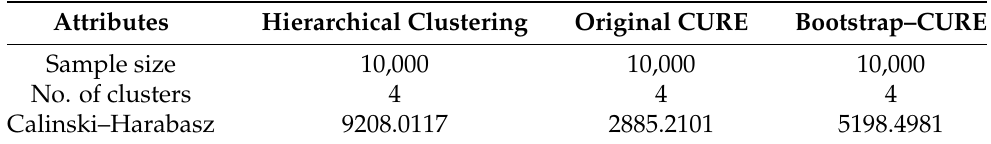
Table 4. Calinski–Harbasz index